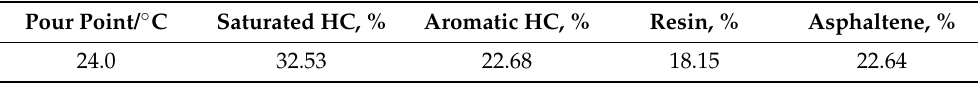
Table 4. Physical properties of heavy oil.